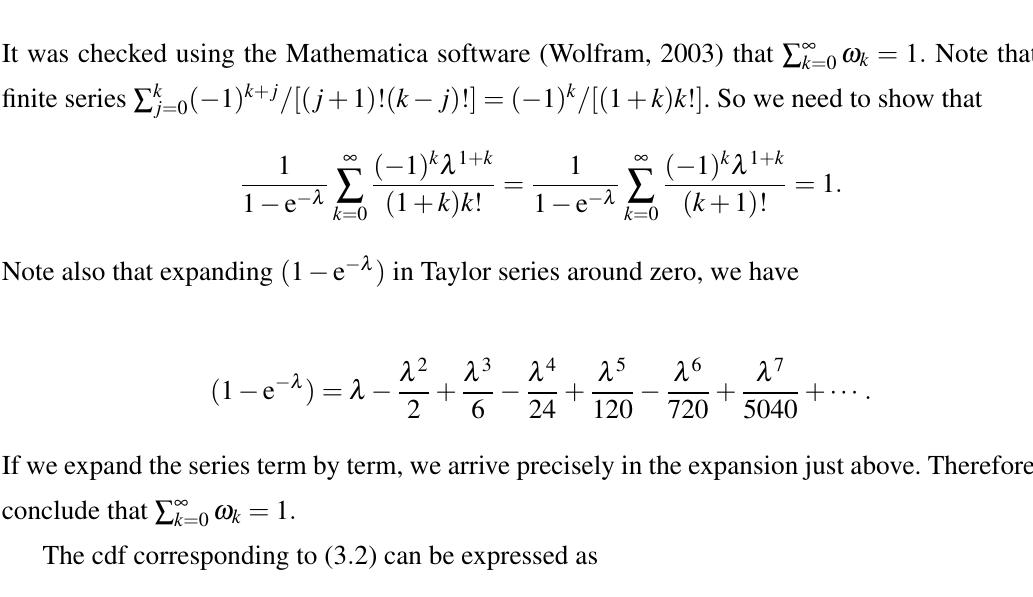
Fig. 3. Plots of the Kw-BP density function for some parameter values. (a) For α = 1 . 5 and β = 0 . 7. (b) For α = 3 . 5 and β = 1 .